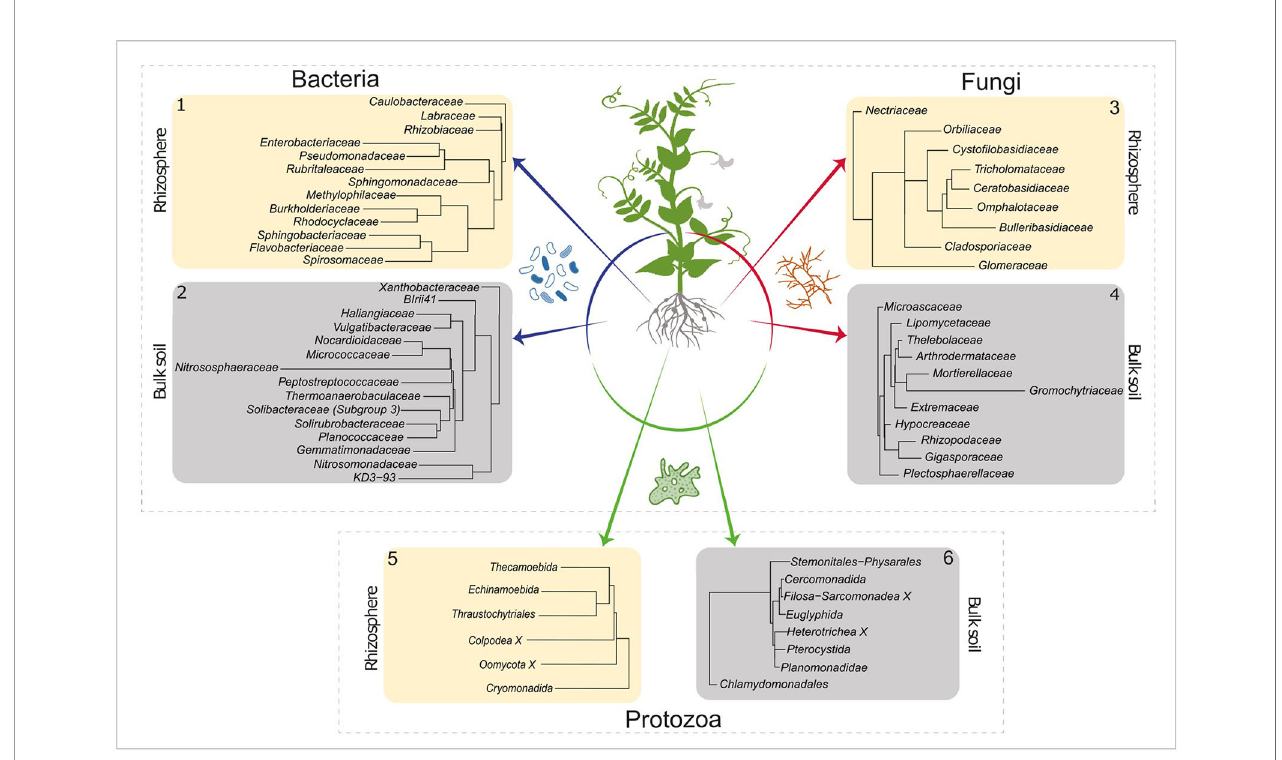
FIGURE 2 | LEfSe analysis of the active bacterial, fungal, and protists OTUs. Identifying taxa for which a major part of the population was active in rhizosphere (ivory square) or in bulk soil (gray square) (LDA score > 2.5). Numbers in the top left or top right corner correspond to the number next to the active communities (ochre and red) in Figure 1 . LEfSe, linear discriminate analysis effect size; OTUs, Operational Taxonomic Units; LDA, linear discriminate